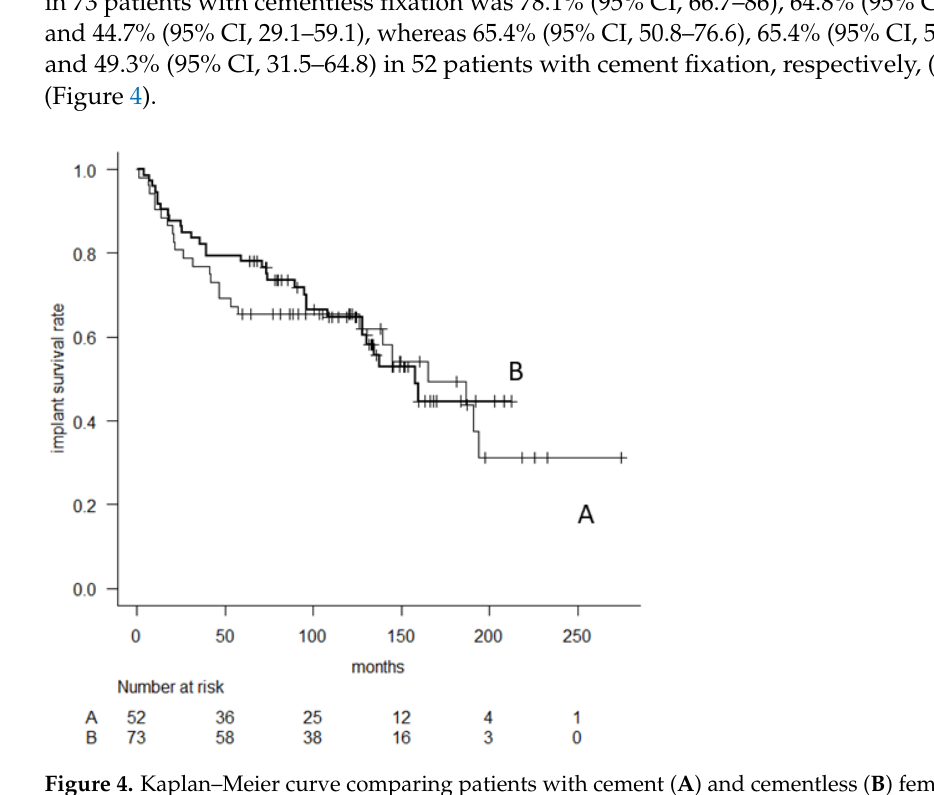
Figure 3. Kaplan–Meier curve showing implant survival rate (major revision).